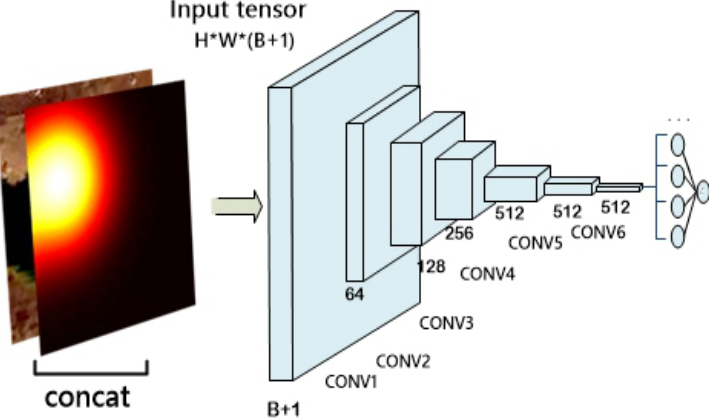
Figure 3. Architecture of the discriminator D in the adversarial framework. The number under each tensor stands for the number of